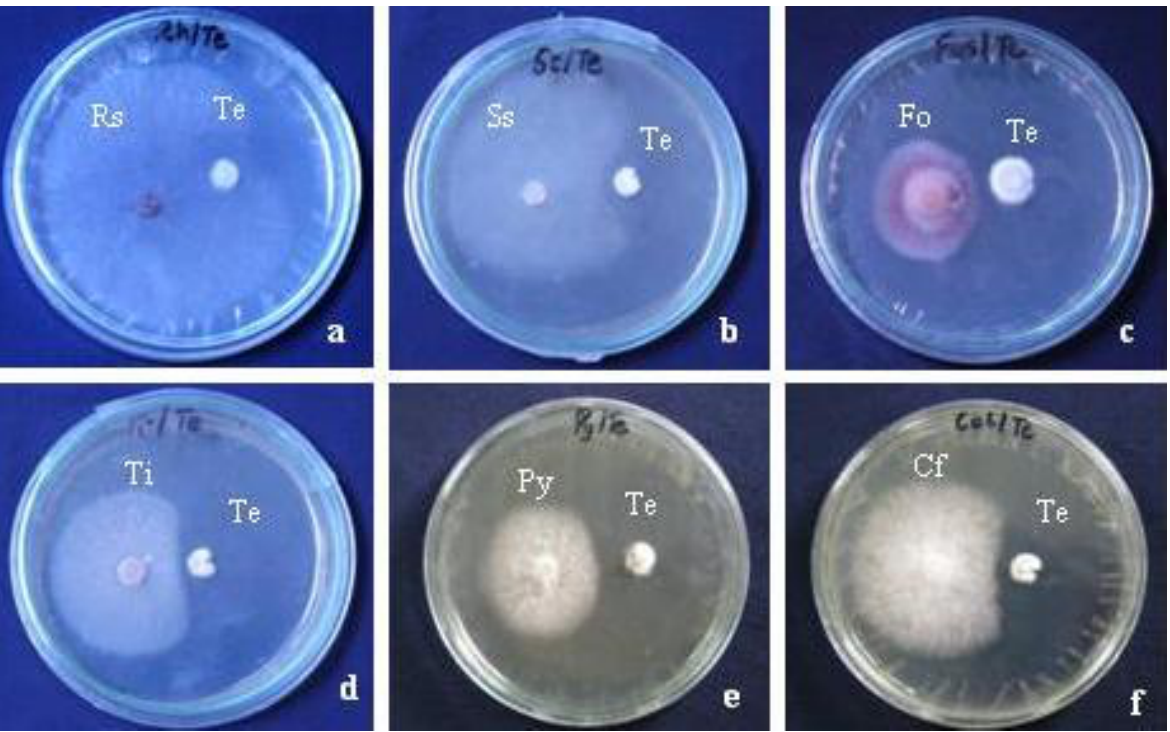
FIGURE 1. Inhibition of plant pathogenic fungi by Tetrachaetum elegans : (a) Rhizoctonia solani , (b) Sclerotinia sclerotiorum , (c) Fusarium oxysporum , (d) Tilletia indica , (e) Pyricularia oryzae , (f) Colletotrichum falcatum .